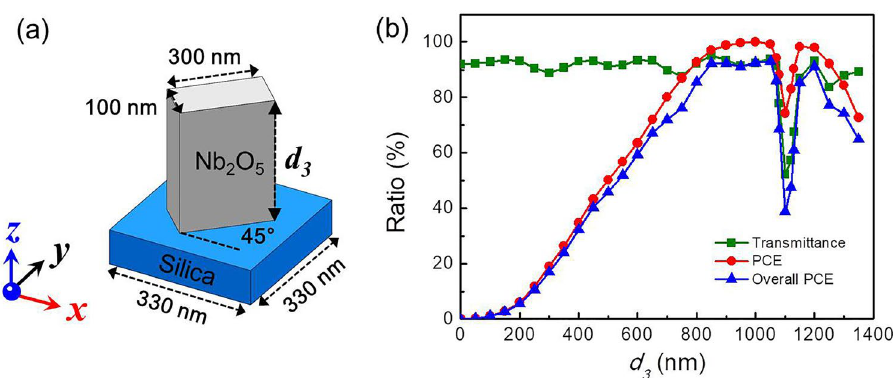
Figure 5. Geometric diagram and optical property of Nb 2 O 5 nano-fin. ( a ) Schematic of a Nb 2 O 5 nano-fin on a silica substrate, where d 3 is the thickness of the Nb 2 O 5 nano-fin. ( b ) Transmittance, PCE, and overall PCE versus the thickness of the Nb 2 O 5 nano-fin. x-polarized light with λ = 633 nm impinges perpendicularly onto the structure from bottom along the positive z-direction.